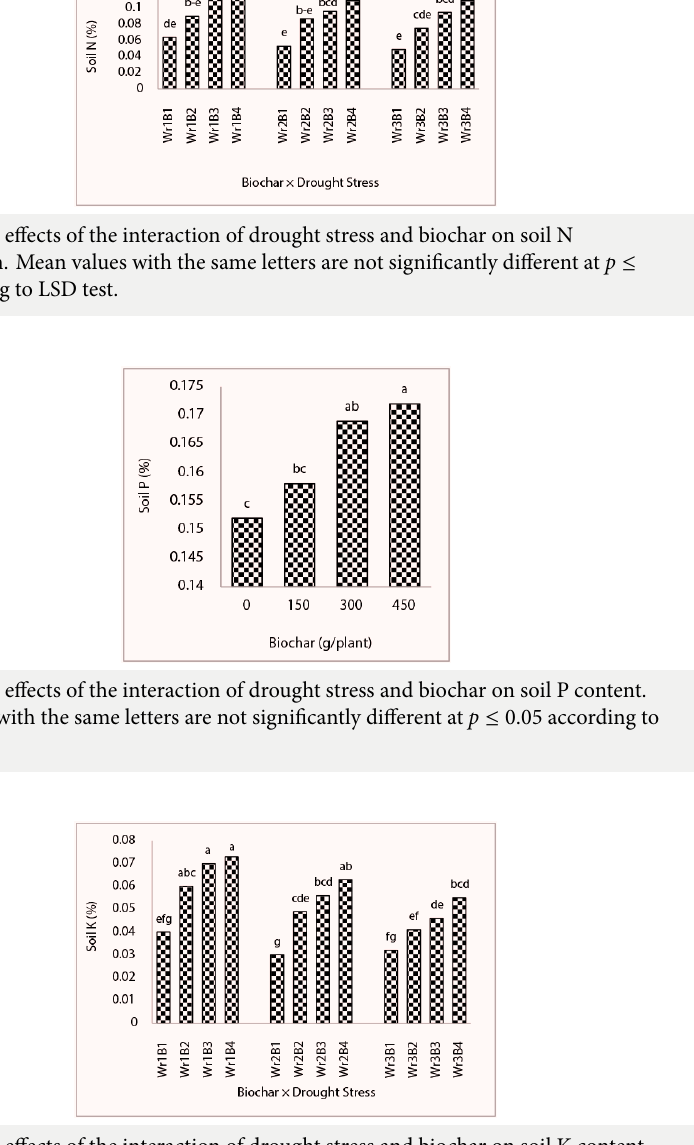
Figure 6 The effects of the interaction of drought stress and biochar on soil K content. Mean values with the same letters are not significantly different at p ≤ 0.05 according to LSD